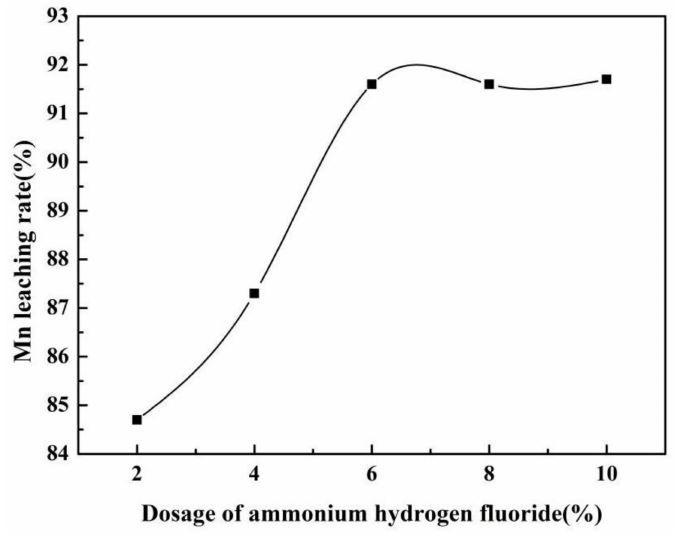
Figure 4. Leaching temperature of 30 ◦ C ammonia concentration of 14 mol/L, liquid–solid ratio of 6:1, stirring rate of 400 r/min, and leaching time of 1 h, and the influence of the addition amount of ammonium hydrogen fluoride on the leaching efficiency of